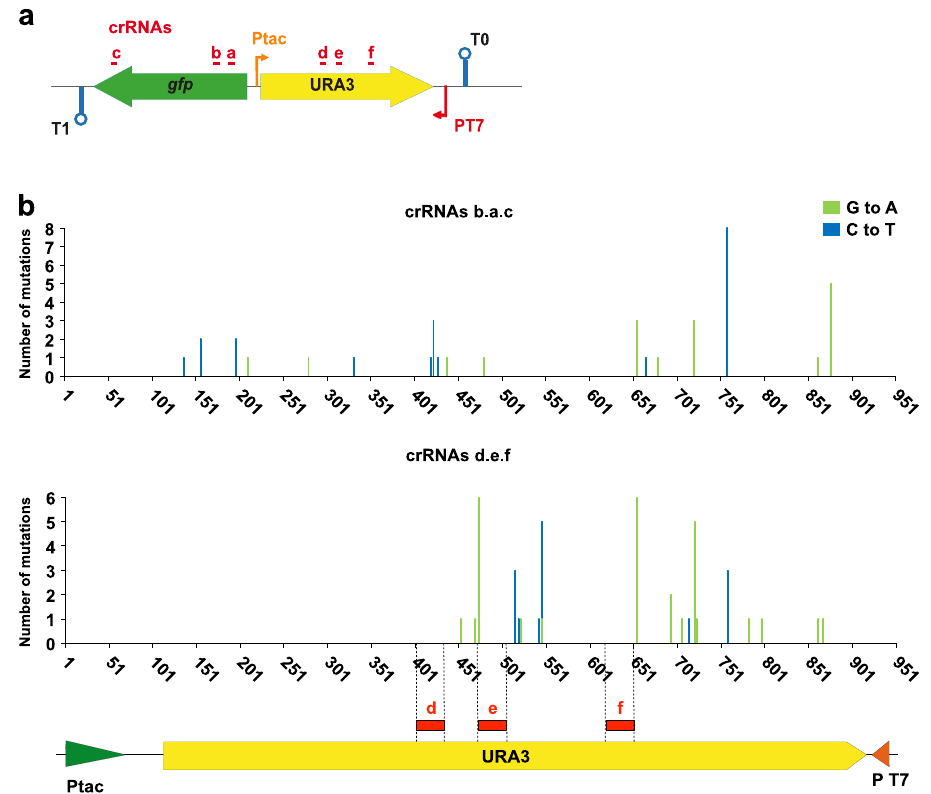
Fig. 6 Protection from mutagenesis of a delimited segment of the target gene by dCas9 guided with crRNAs. a Scheme of the URA3 cassette with the recognition sites (red lines) of the triple crRNAs b.a.c and d.e.f. Thin arrows indicate the tac (P tac ) and T7 (P T7 ) promoters, lollipop shapes indicate terminators T0 and T1. The genes gfp and URA3 are represented with green and yellow fi lled arrows, respectively. b URA3 mutations found in FOA R colonies of induced cultures of MG*-SacB-URA3 Δ ung Δ n fi expressing AID-T7RNAP and the corresponding tripe crRNAs. For each culture the URA3 alleles from 30 colonies were sequenced. The indicated base changes correspond to the coding sequence of URA3 . Different base substitutions found are labeled with the color code on the right. The promoters Ptac and T7 are shown with green and red arrow heads, respectively. The gene URA3 is shown with a yellow fi lled arrow. Red rectangles over the URA3 gene mark targeting sequences of the crRNAs d, e, and f, and delimited with dashed lines. Source data are provided as a Source data fi